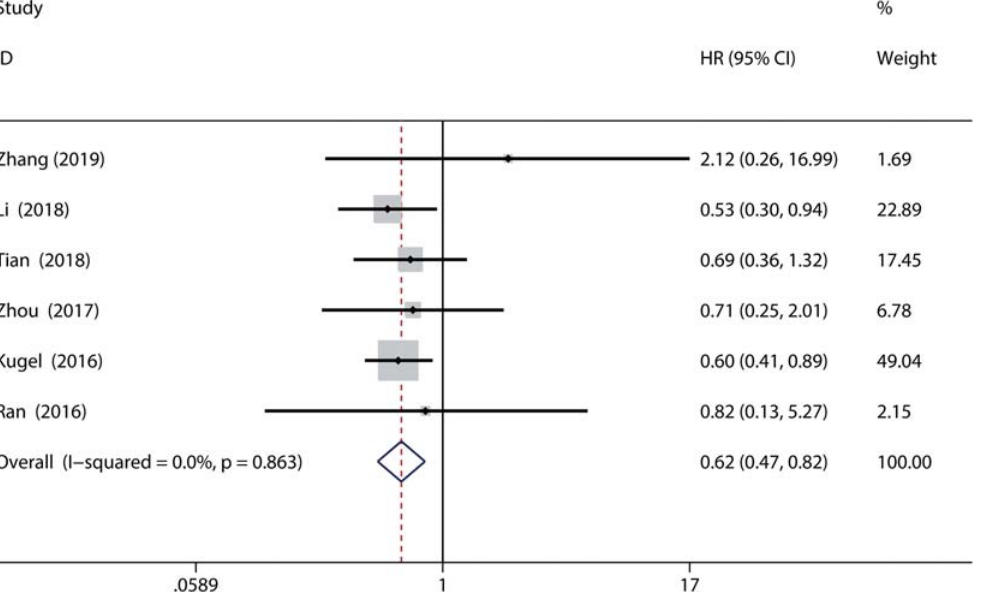
Figure 2: Forest plot for the association between SIRT6 expression and OS in gastrointestinal cancers. Solid diamonds: the HR of each study; squares: weight of each study; horizontal line: the 95% CI of each study; dotted line: the pooled HR; and un fi lled diamond: the pooled results for all studies.